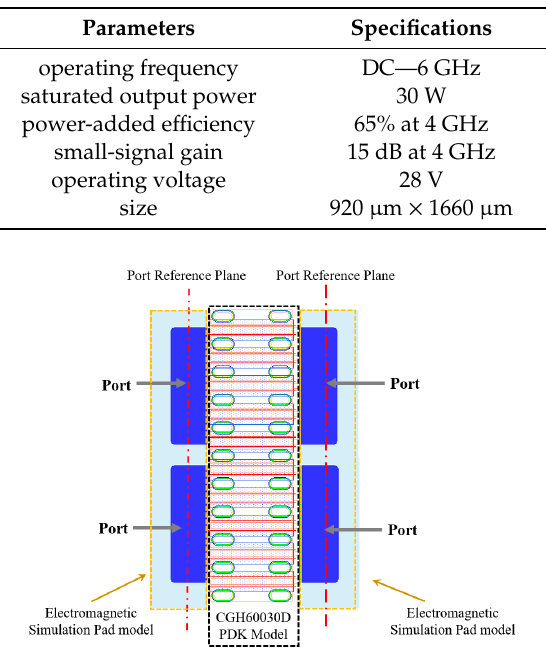
Figure 2. Modified large-signal transistor model with a foundry process design kit model and electromagnetic simulation pad models. Table 1. Device parameters of CGH60030D.